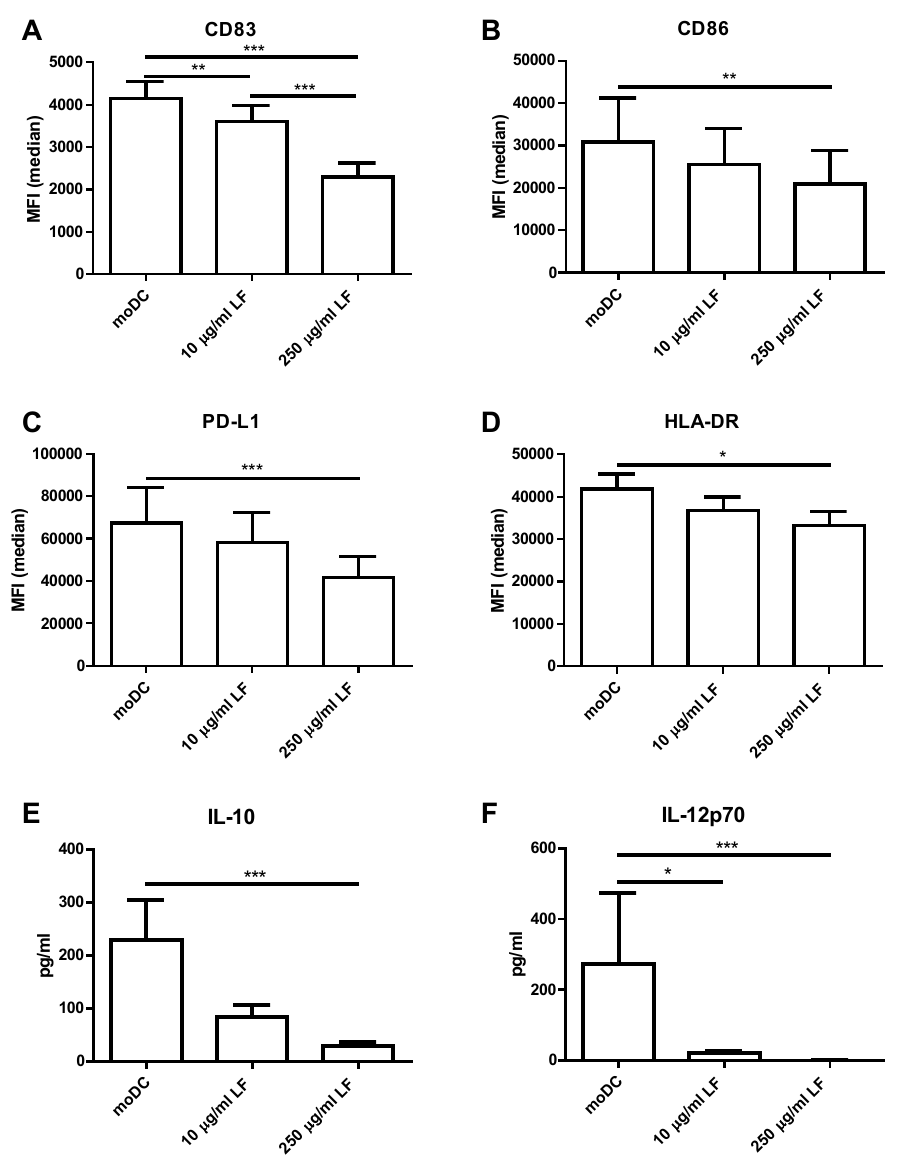
Figure 2. LFDC are hyporesponsive for LPS stimulation. Immature DC that were cultured in the presence or absence of LF were stimulated with 1 µg/mL LPS for 48 h. ( A ) The median fluorescent intensity (MFI) of ( A ) CD83, ( B ) CD86, ( C ) PD-L1 and ( D ) HLA-DR was shown. The production of ( E ) IL-10 and ( F ) IL-12p70 was measured in the supernatant by CBA. The mean ± SEM of four independent experiments with 12 different donors was shown. Significance is indicated by *** = p < 0.001, ** = p < 0.01 and * = p < 0.05.